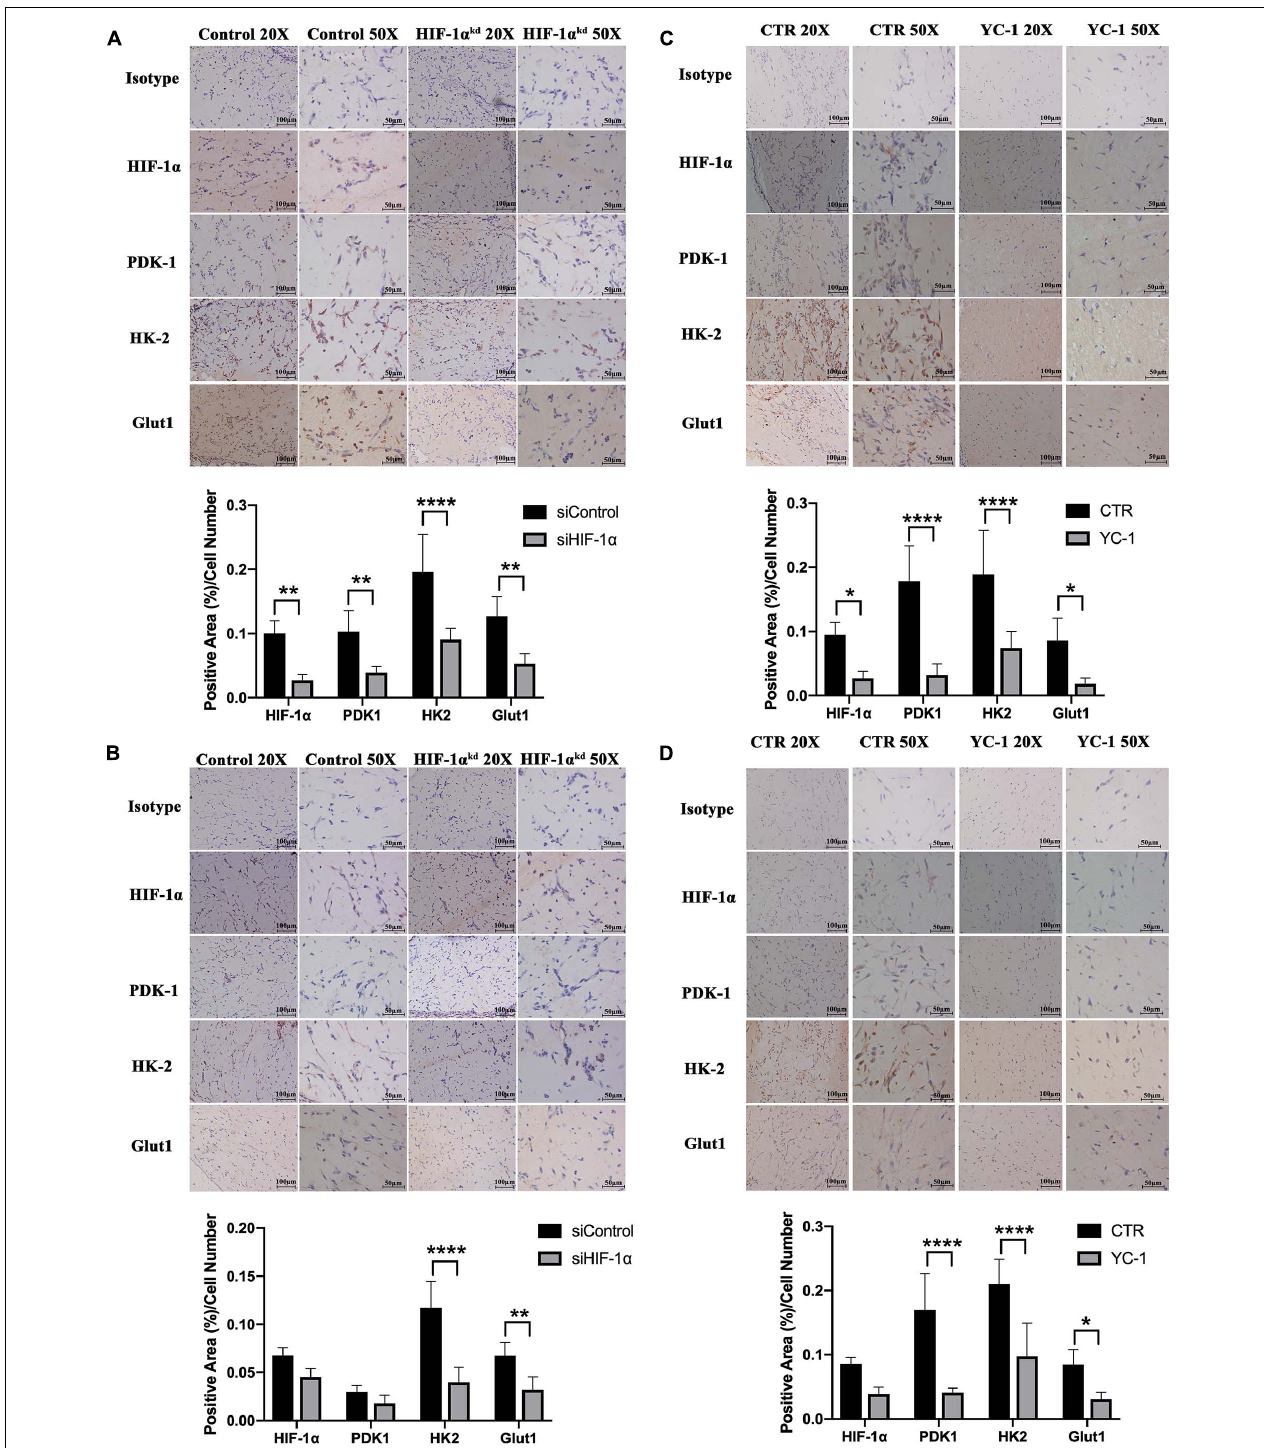
FIGURE 2 | Silencing or chemical inhibition of HIF-1 α down-regulated the proteins important in metabolic adaptations in vivo . Immunohistochemistry for HIF-1 α , PDK-1, HK-2, and Glut-1 in siControl and si-HIF-1 α SHED containing Matrigel plugs at (A) 3 days and (B) 7 days, and CTR and YC-1 SHED containing groups at (C) 3 days and (D) 7 days of transplantation. * p < 0.05, ** p < 0.01, and **** p < 0.0001. Scale bar: 20 × = 100 µ m, 50 × = 50 µ m.